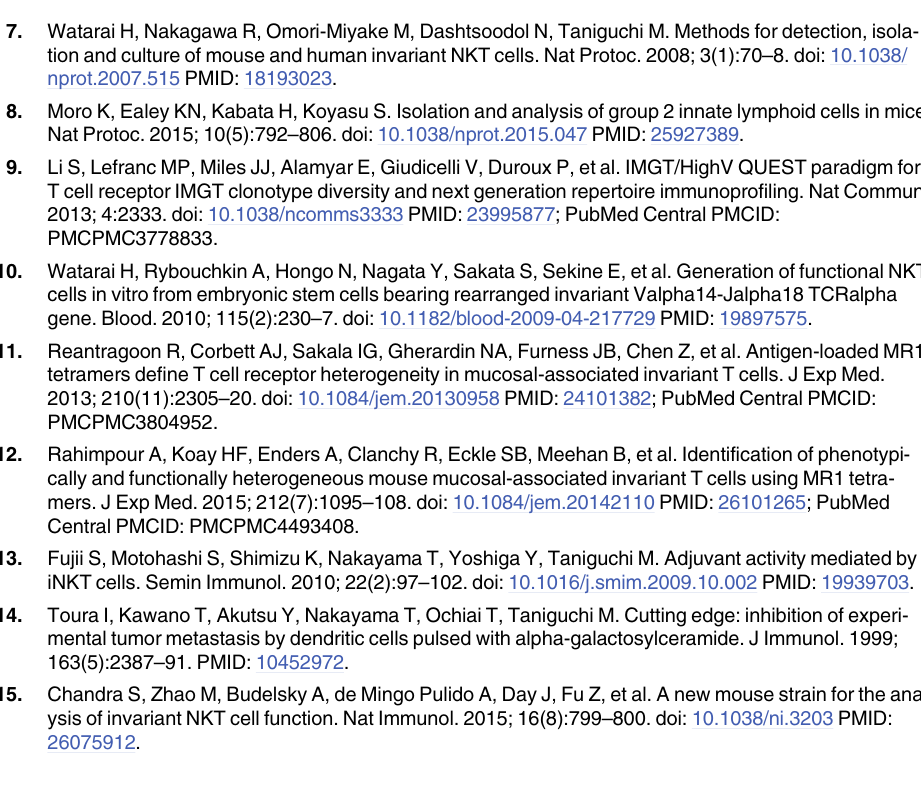
PLOS ONE | DOI:10.1371/journal.pone.0153347 April 11, 2016 10 /